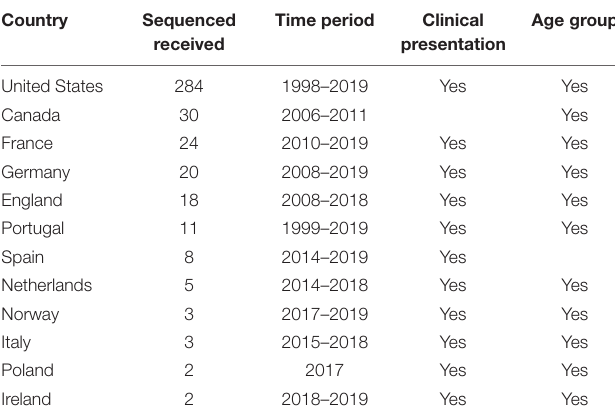
TABLE 1 | Sequences received and metadata used in the study.